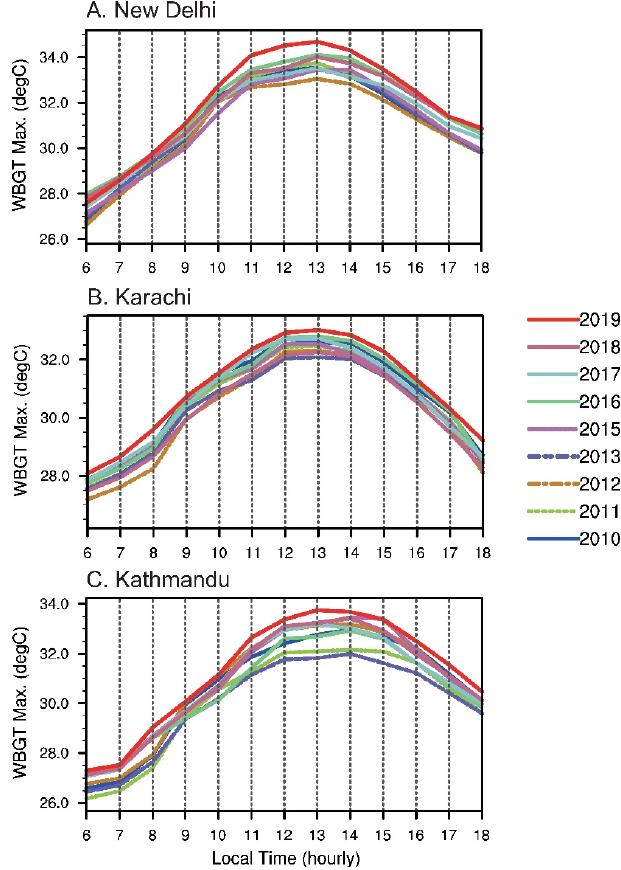
Figure 5. Decadal variability of diurnal cycle of JJA averaged-maximum WBGT* during the 2010s. The cold snap in the year 2014 described in Section 3.1 is not shown here for the WBGT* scale: ( A ) New Delhi, ( B ) Karachi, and ( C ) Kathmandu.